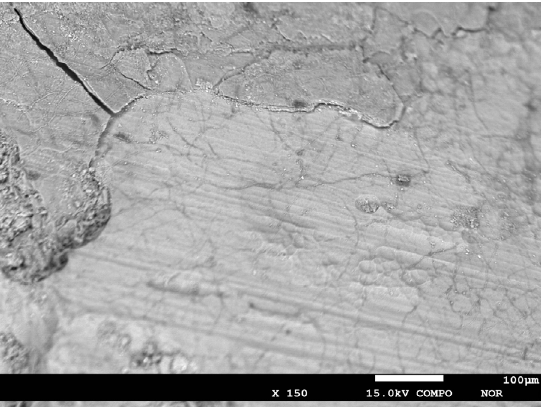
Figure 6: EPMA image of a de-alkalized surface of fragment USPAR-08.